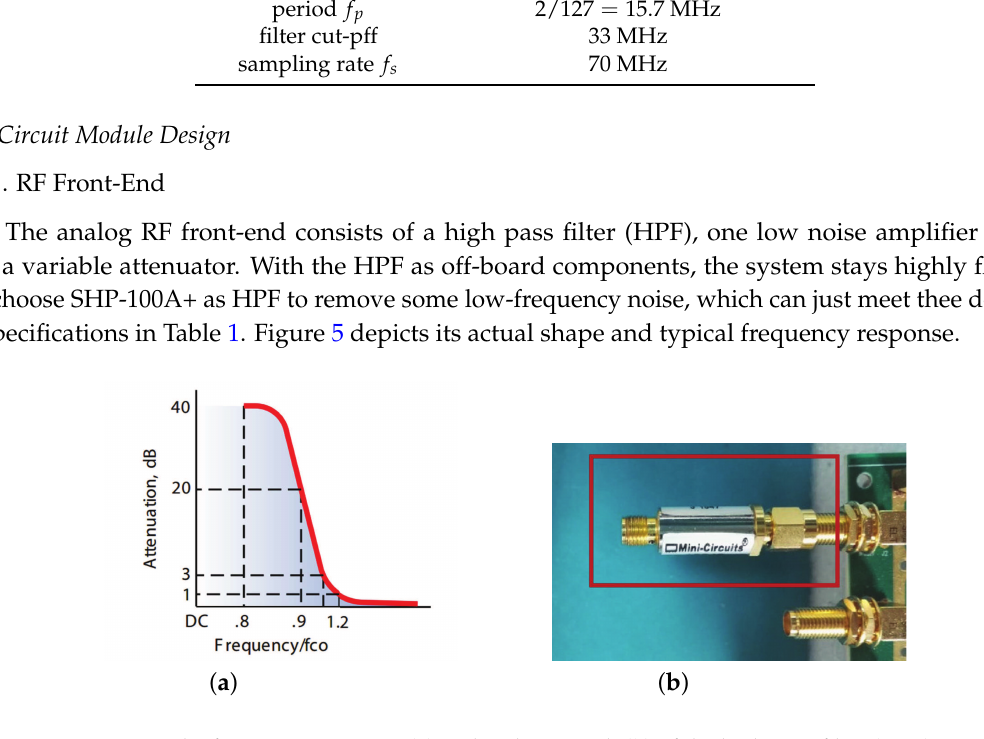
Figure 5. The frequency response ( a ) and a photograph ( b ) of the high pass filter (HPF).